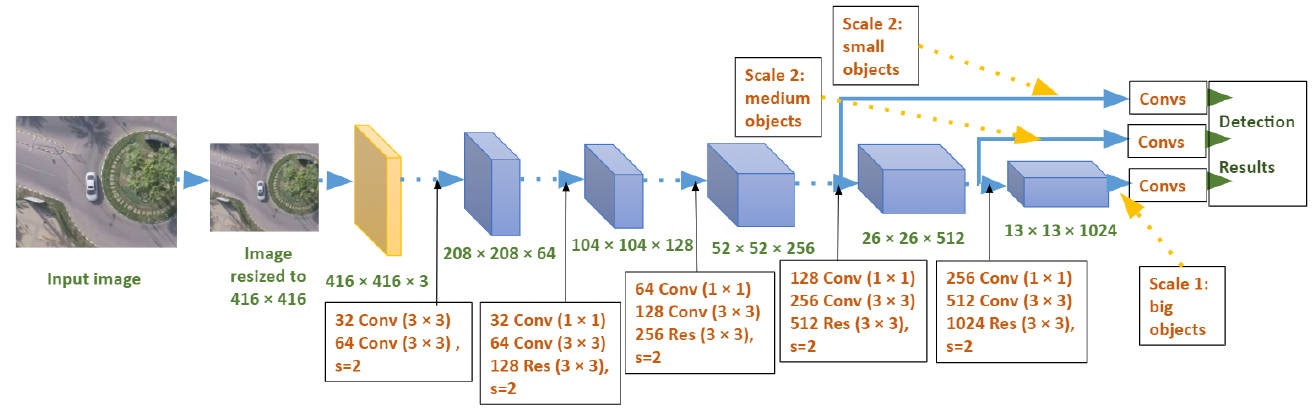
Figure 2. YOLOv3